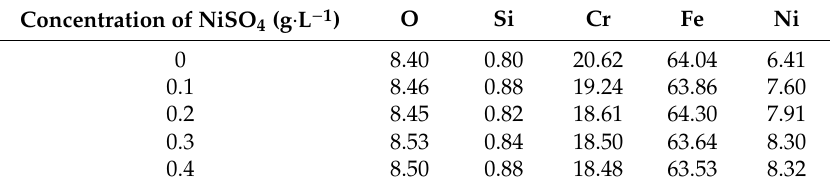
Table 5. Friction numbers for the di ff erent colored specimens recorded before